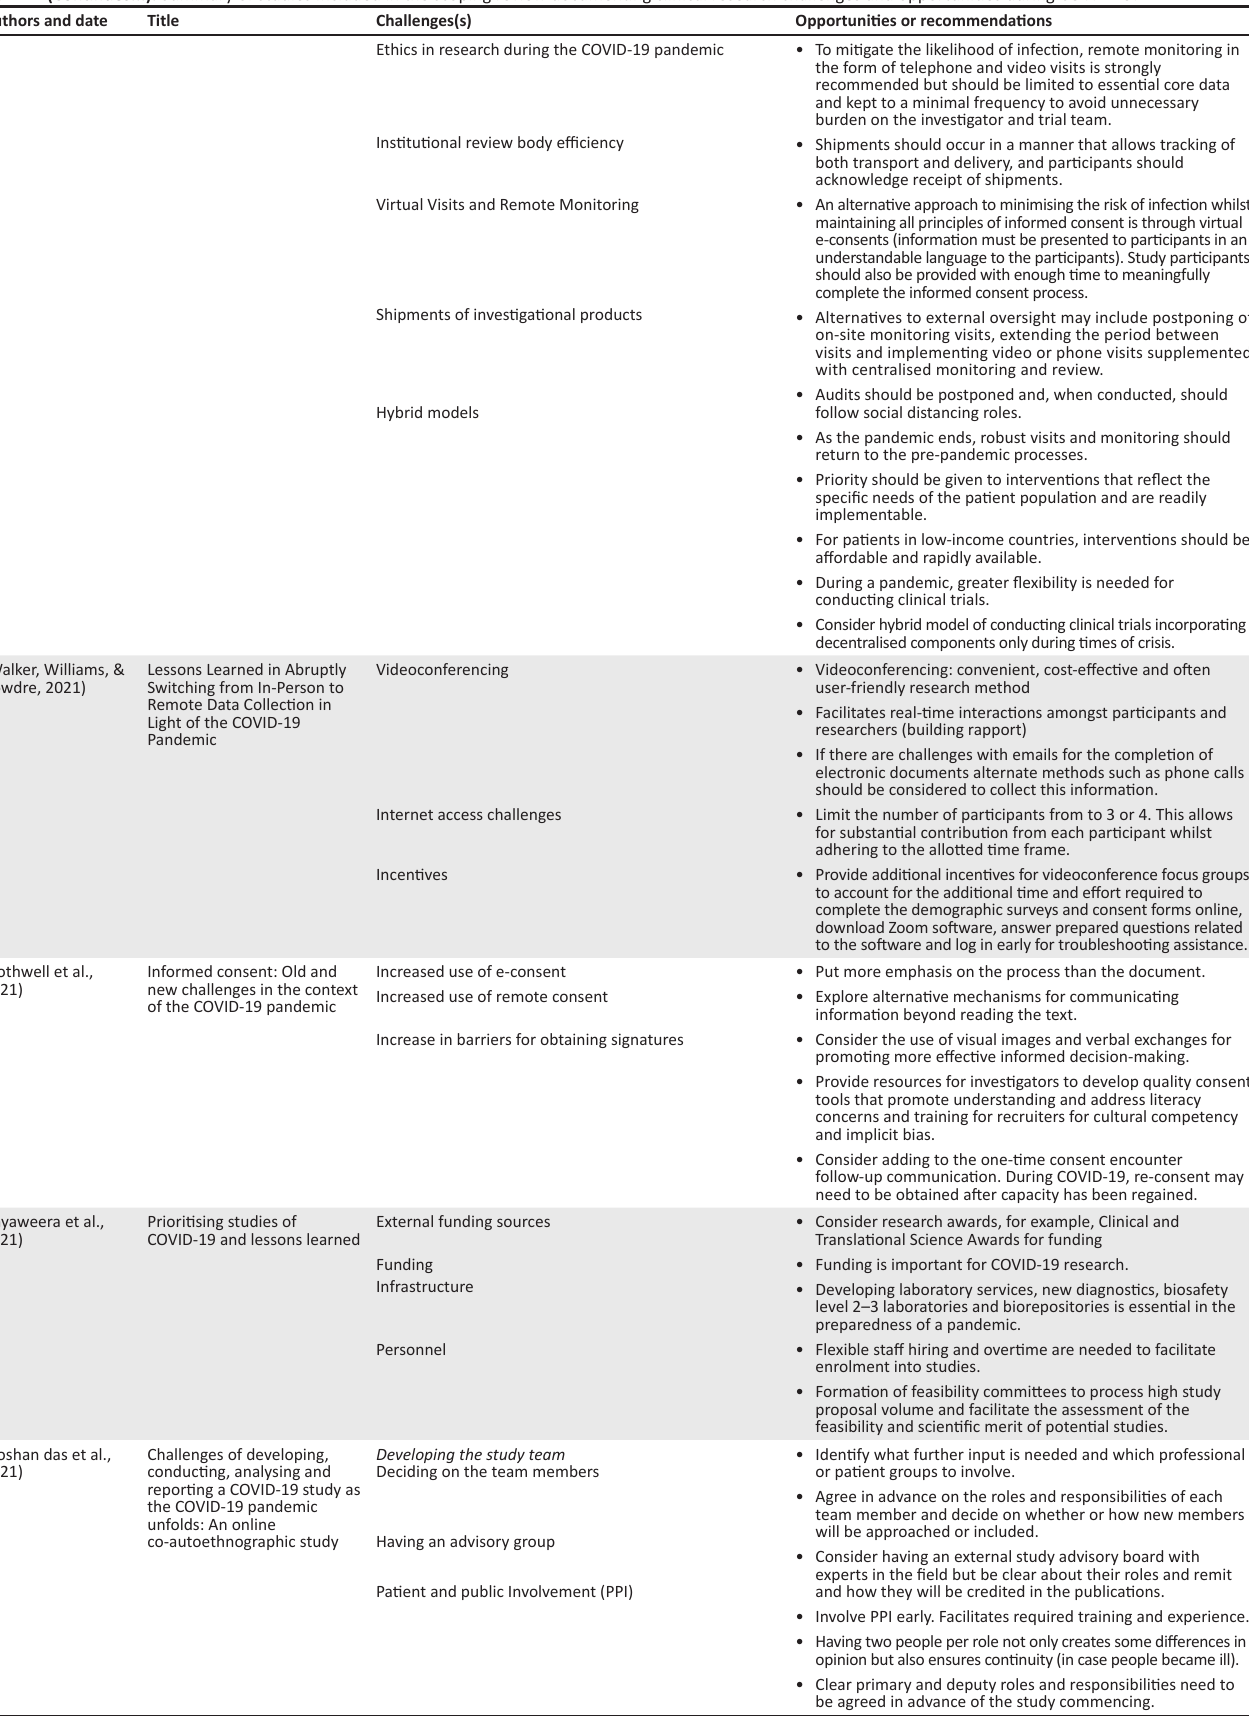
TABLE 1 (Continues...): Summary of studies included in the scoping review documenting clinical research challenges and opportunities during